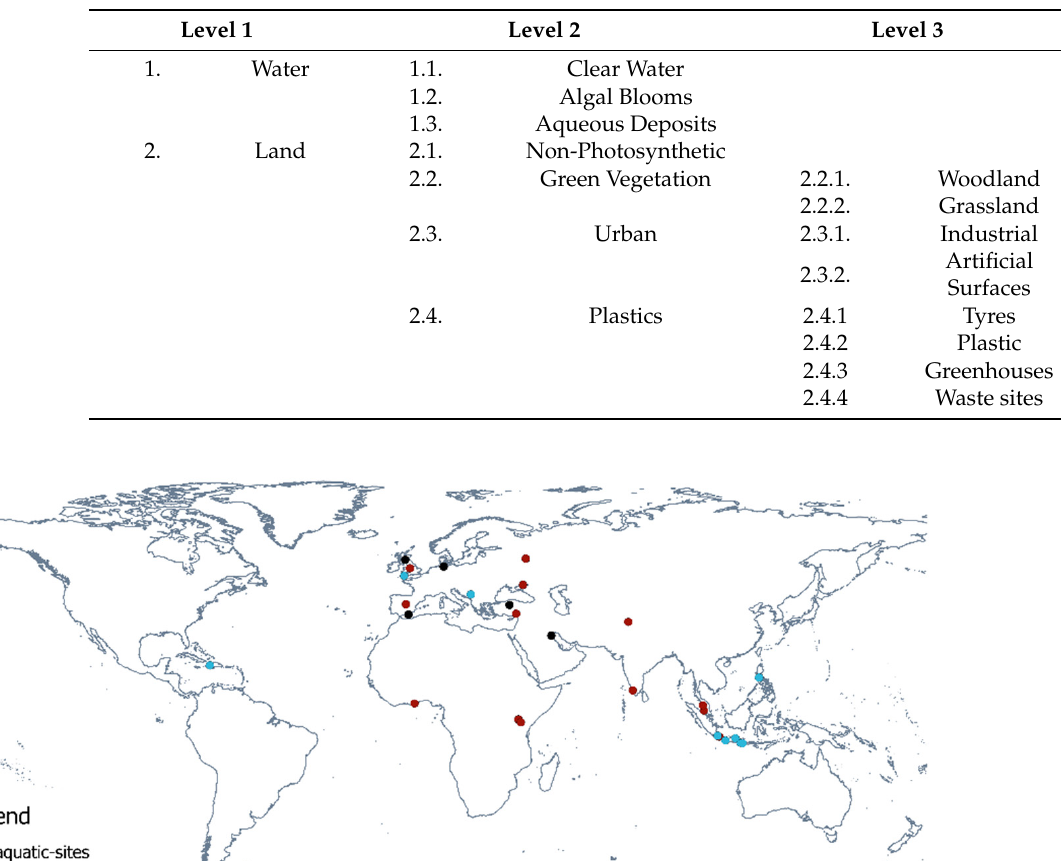
Table 3. Classification of the land cover types through a tiered approach following CORINE, with an additional Level 2 class for plastics.